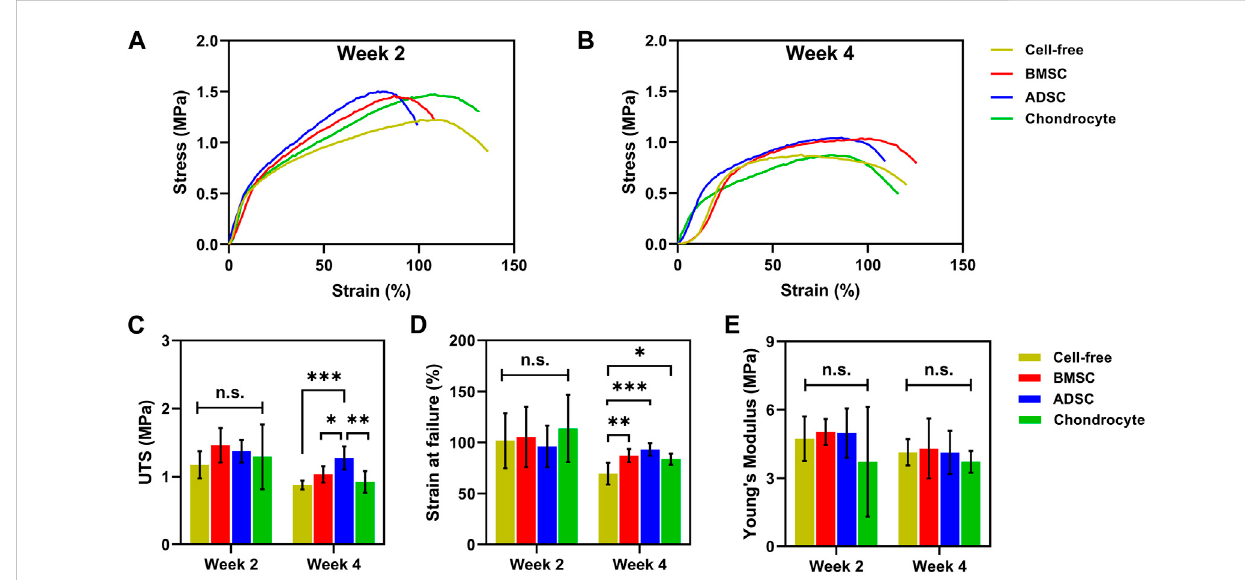
FIGURE 7 Biomechanics of cell-seeded scaffolds. Cell-seeded scaffolds show similar typical stress-strain curves to cell-free scaffolds (A) . BMSC and ADSC- seeded scaffolds exhibit greater UTS (C) and breaking strains (D) than cell-free scaffolds at day 28. No signi fi cant change in Young ’ s modulus is observed between cell-seeded and cell-free scaffolds (E) . * p < 0.05, ** p < 0.01, *** p <